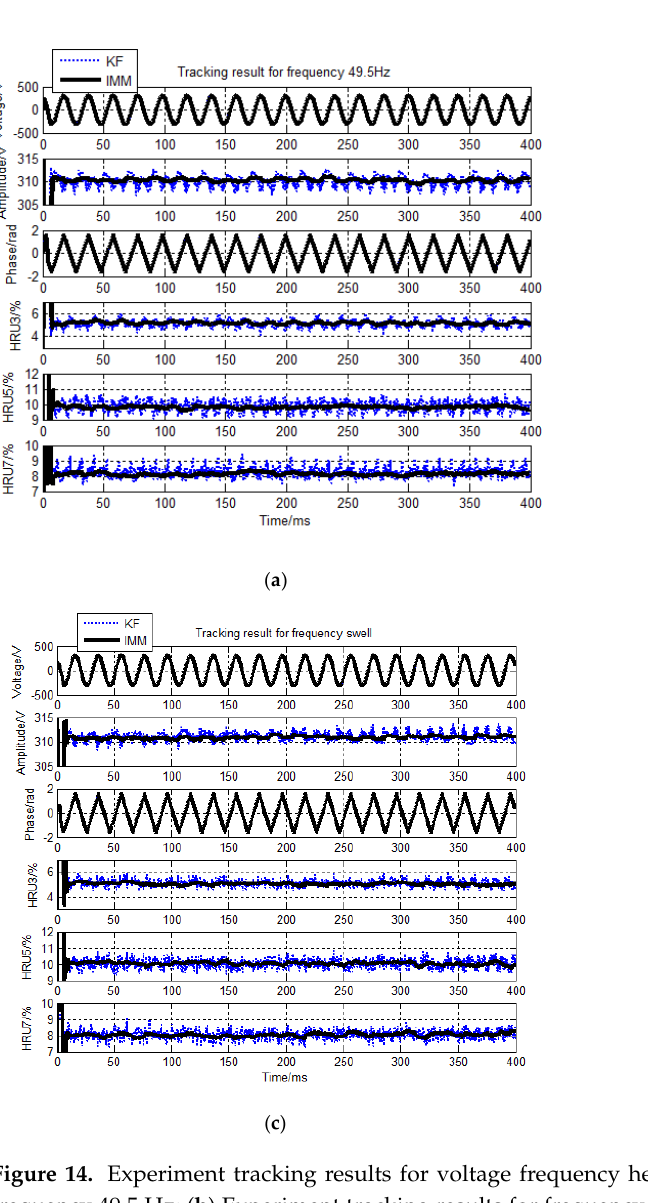
( d ) Figure 15. Experiment tracking results for voltage frequency slight fluctuations. ( a ) Experiment tracking results for fre- quency 49.98 Hz; ( b ) Experiment tracking results for frequency 50.02 Hz; ( c ) Experiment tracking results for frequency swell; ( d ) Experiment tracking results for frequency sag.